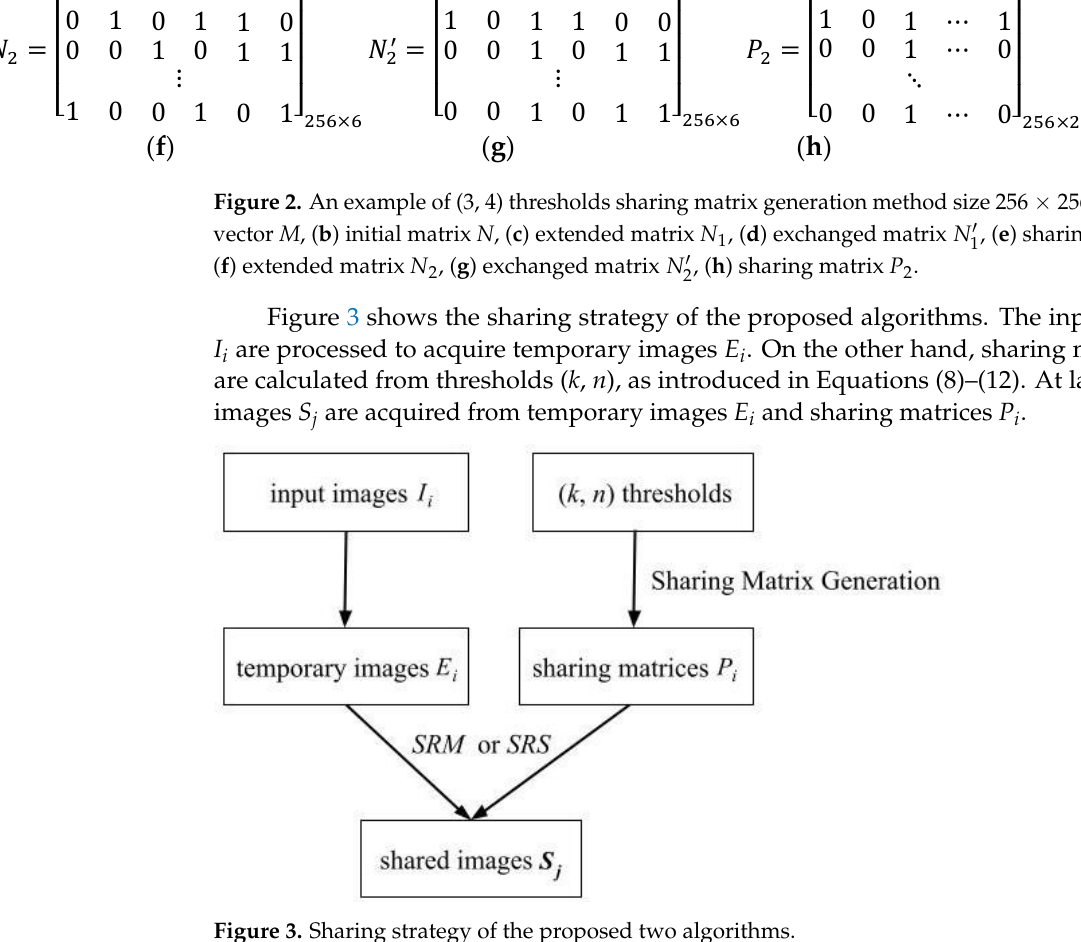
Figure 3. Sharing strategy of the proposed two algorithms.